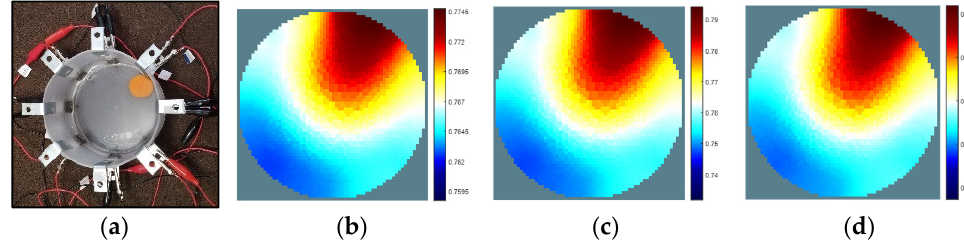
Figure 11. A carrot slice at ( a ) pos: 1, and the reconstructed images for the stimulation current of ( b ) 0.5 mA, ( c ) 1 mA, and ( d ) 2 mA at 80 kHz considering GN: Laplace ( λ = 0.57). The shape of the inhomogeneity changes with the increase in current (a slight change is observed). The conductivity is increased, and the obtained maximum conductivity values are 0.77, 0.79, and 0.85 S/m, respectively. Figure 12. A carrot slice at ( a ) pos: 7, and the reconstructed images for the hyperparameter value ( λ ) of ( b ) 0.97, ( c ) 0.57, and ( d ) 0.17 at 80 kHz and 1 mA considering Laplace algorithm. The shape of the inhomogeneity changes with the decrease in hyperparameter value. The conductivity is increased, and the obtained maximum conductivity values are 0.71, 0.73, and 0.9 S/m, respectively. Experiment 2: In another experiment, three different edible plant slices of carrot, radish, and potato of a 1/3-inch height with a diameter, D = 25.4 mm of each were taken